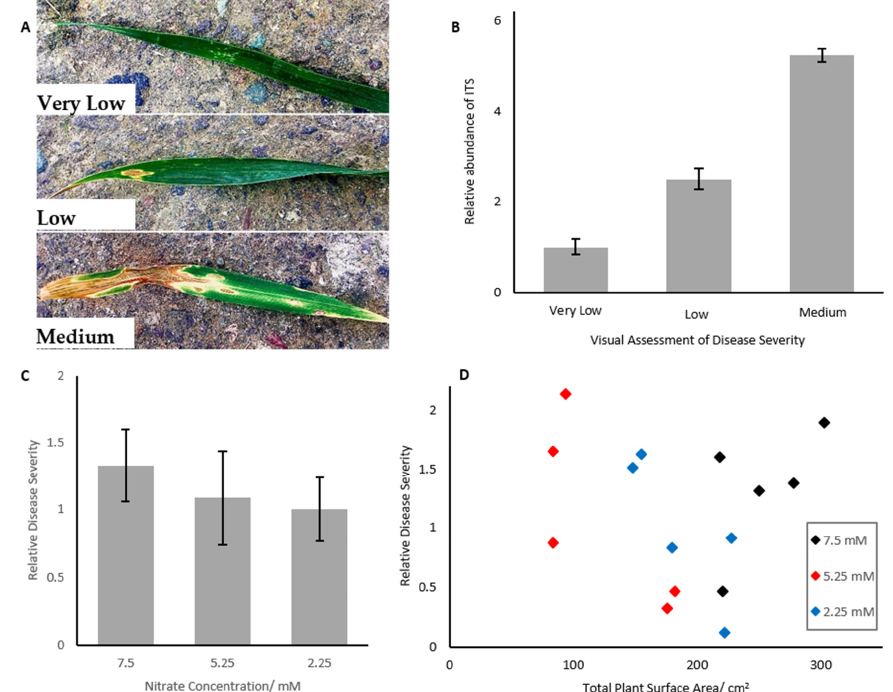
Figure 1. ( A ) Representative images of Very Low, Low and Medium levels of Septoria infected wheat leaves. ( B ) Abundance of Septoria ITS region in wheat samples infected with Septoria. ITS abundance increases with increasing disease severity. Error bars represent ± 1 standard deviation. n = 3. Di ff erent letters represent statistically significantly di ff erent means ( p < 0.05). Means compared via ANOVA, n = 3 ( C ) Wheat grown for 35 days under di ff erential nitrogen concentrations did not show significantly di ff erent levels of Septoria ( p < 0.05), analysed by expression of the Septoria ITS region. Error bars represent ± 1 SEM. Di ff erent letters represent statistically significantly di ff erent means ( p < 0.05). Means compared via ANOVA, n = 5. ( D ) Septoria severity in wheat did not correlate with total surface area of the plant for wheat grown for five weeks under di ff erential nitrogen treatment. slope coe ffi cient was not significantly di ff erent from 0 ( p =